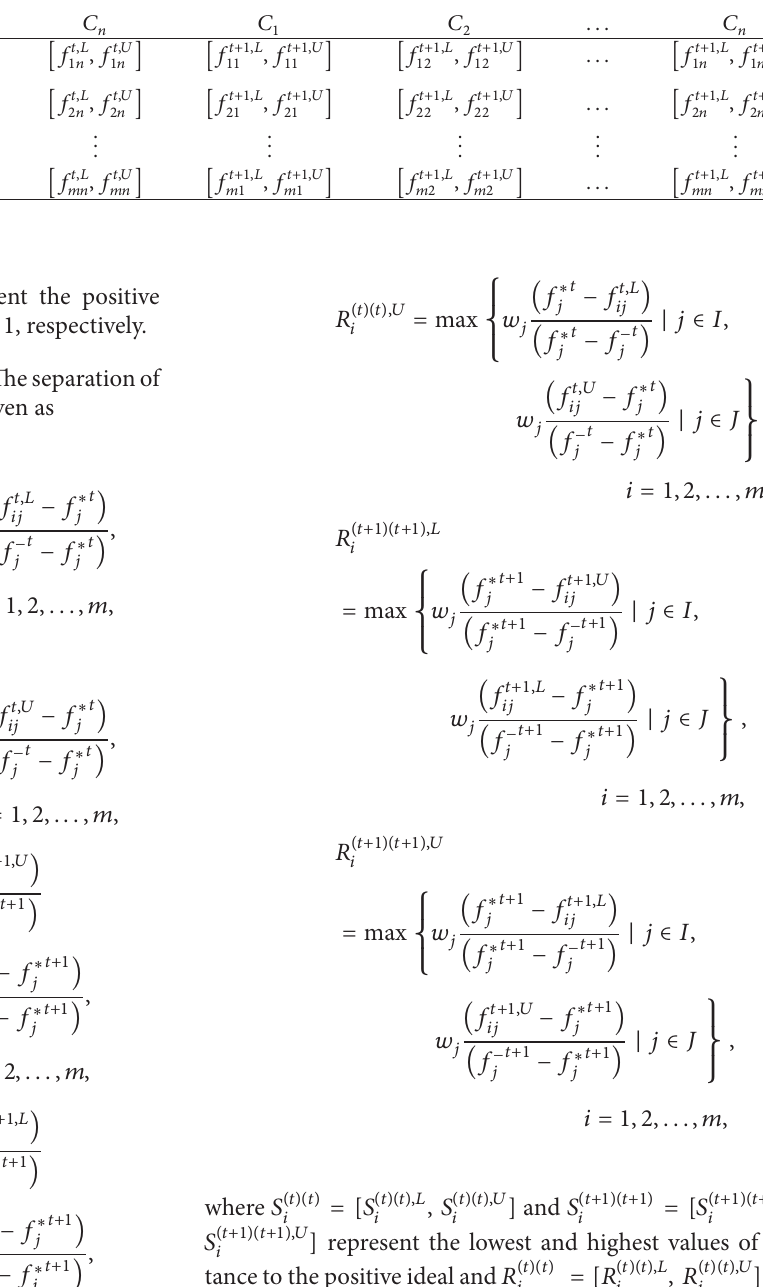
Table 3: Matrix format of a MADM problem with interval data in times 𝑡 and 𝑡 + 1 . 𝑡 𝑡 + 1 𝐶 𝐶 1 2